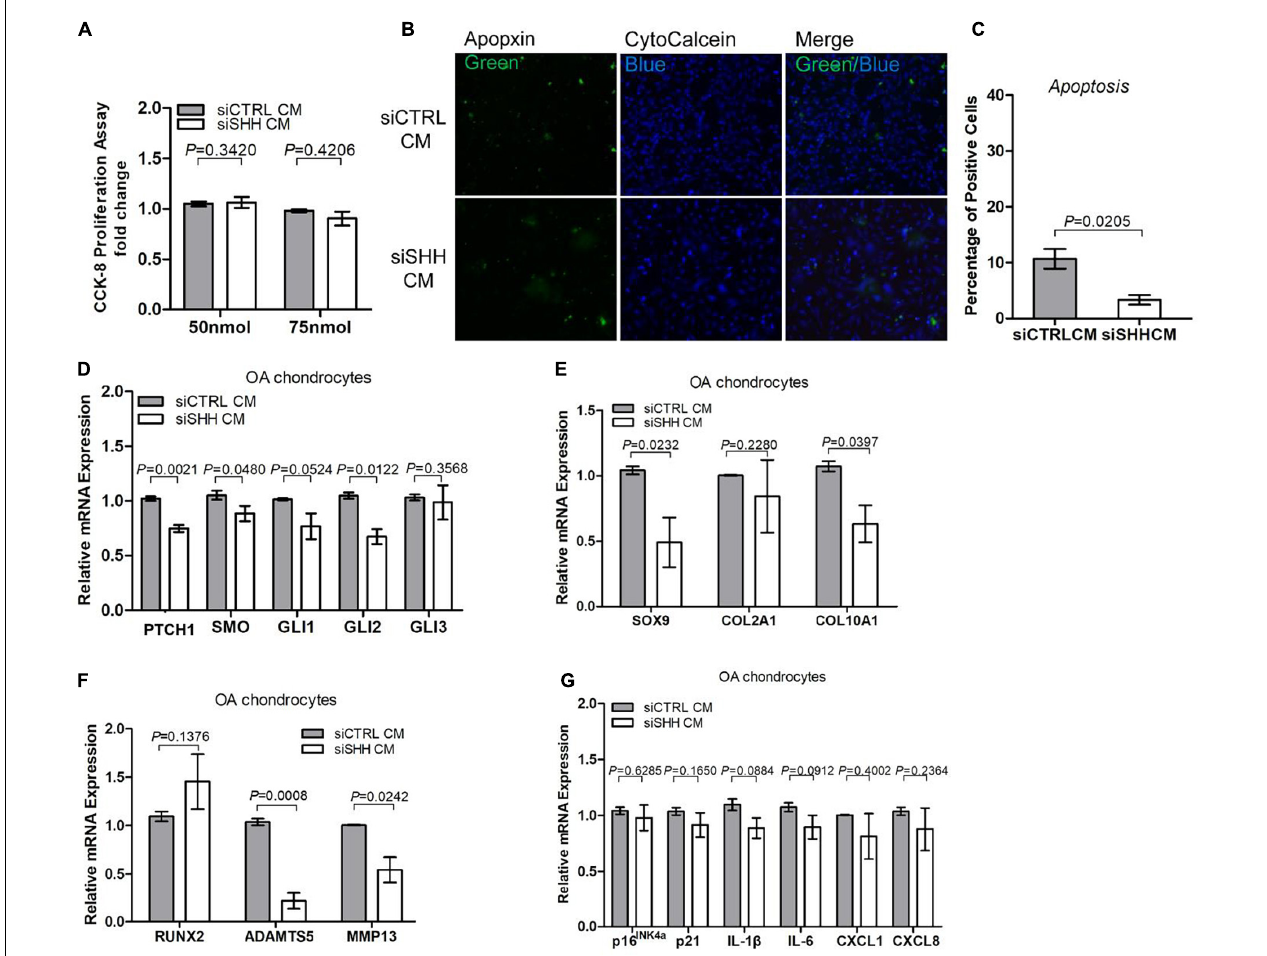
FIGURE 6 | Knocking down sonic hedgehog (SHH) in osteoarthritis mesenchymal stromal cell (OA-MSC)-derived conditioned medium inhibited chondrocyte apoptosis and expression of hedgehog (HH) signaling and catabolic genes in osteoarthritic chondrocytes (OAC). (A) Knocking down SHH in OA-MSC-derived conditioned medium did not affect OAC proliferation. OA-MSC-derived conditioned medium was collected from OA-MSC transfected with SHH-siRNA (siSHH CM) or scrambled control siRNA (siCTRL CM). Two dosages of siRNA (50 and 75 nmol) were tested. OACs were incubated in the conditioned medium for 24 h. (B) Knocking down SHH in OA-MSC inhibited OAC apoptosis induced by OA-MSC CM. Fluorescence cytochemical analysis of chondrocyte apoptosis induced by OA-MSC-derived CM (siCTRL CM and siSHH CM). Alive chondrocytes were stained blue with Cytocalcein violet 450, while apoptotic cells were stained green with Apopxin green indicator. Scale bars = 125 µ m. (C) Quantification of the apoptosis rate of OAC incubated in siCTRL CM and siSHH CM derived from OA-MSC. p -value is indicated ( n = 3). Real-time reverse transcriptase-polymerase chain reaction (RT-PCR) analysis of transcripts encoding markers of HH signaling (D)